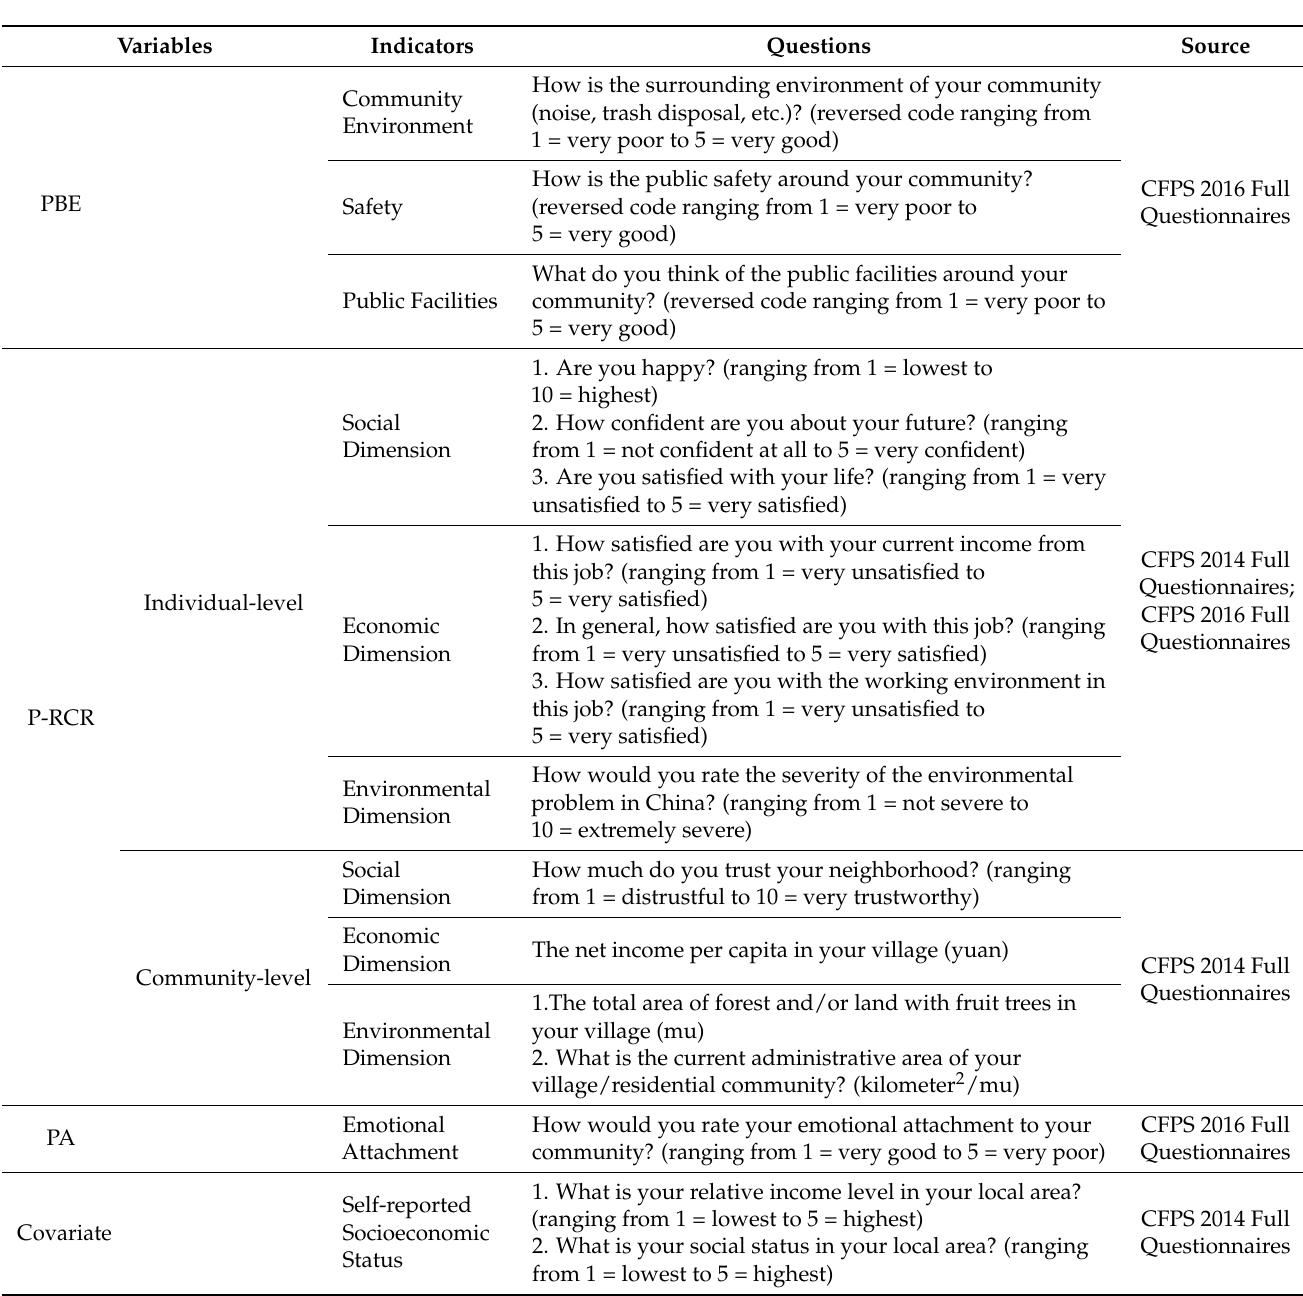
Table 3. Questions used to derive indicators of PBE, PA, P-RCR and the